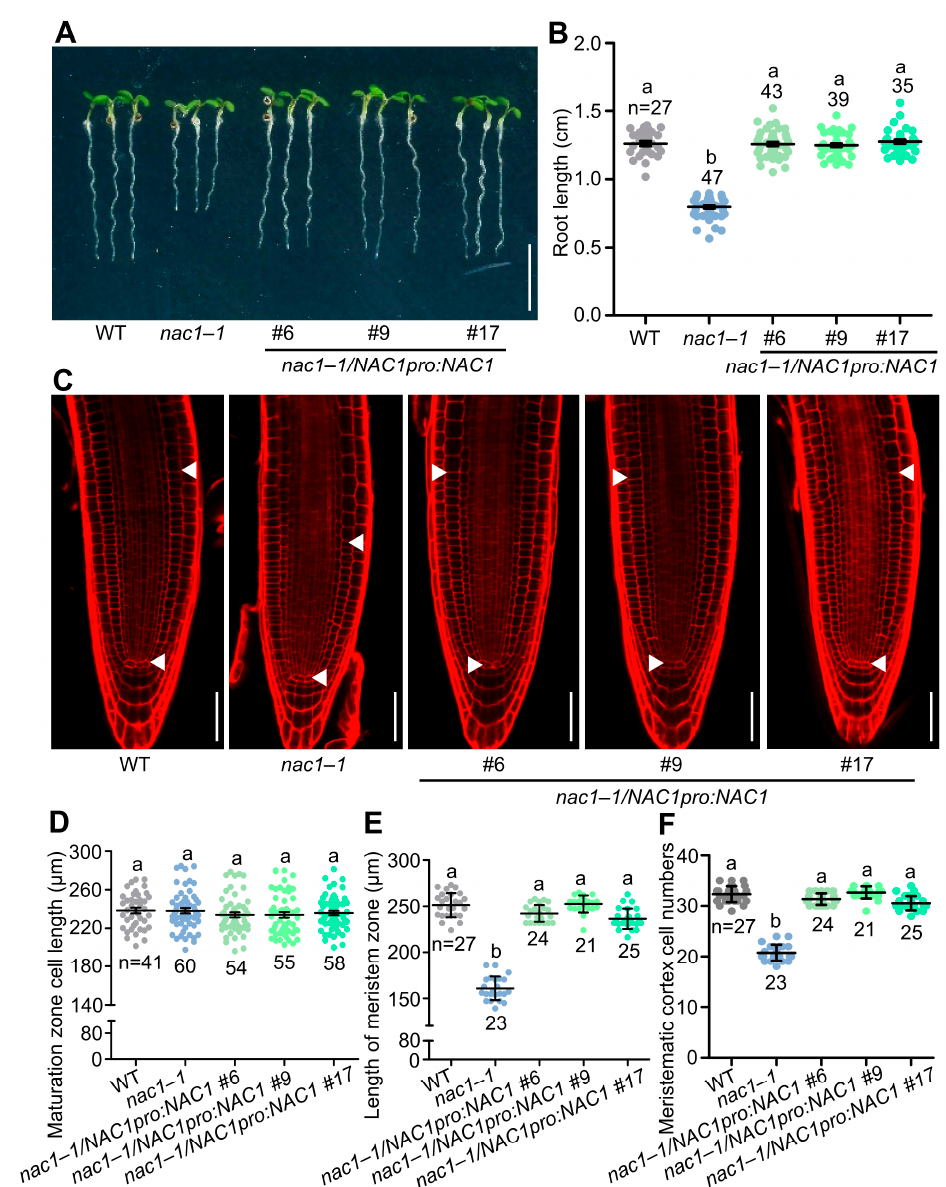
Figure 2. NAC1pro:NAC1 rescues the short-root-length phenotype in nac1 – 1 . ( A ) The root growth phenotypes of WT, nac1 – 1 , and three biological translational transgenic lines of NAC1pro:NAC1 in nac1 – 1 mutant background grown on 1/2 MS medium. The seedlings were photographed at 5 dpg. Scale bar represents 0.5 cm. ( B ) Measurements of primary root length of WT, nac1 – 1 , and three biological translational transgenic lines of NAC1pro:NAC1 in nac1 – 1 mutant background as shown in ( A ). ( C ) Confocal images of root tips of WT, nac1 – 1 , and three biological translational transgenic lines of NAC1pro:NAC1 in nac1 – 1 mutant background as shown in ( A ). The seedlings were used at 5 dpg for imaging. White arrows indicate the boundary between root meristem and transition zones. White arrows below indicate the QC. Scale bars represent 50 µ m. ( D ) Root cortical cell length in the maturation zone of 5 dpg seedlings as shown in ( C ). ( E ) Length of meristem zone of 5 dpg seedlings as shown in ( C ). ( F ) Cell numbers in the proliferation domain of 5 dpg seedlings as shown in ( C ). Data information: in ( B , D – F ) data represent mean ± SD, n denotes the total number of scored samples. Individual values (black dots) are shown. Different lowercase letters indicate significant differences by one-way ANOVA followed by Tukey’s multiple comparison test ( p <